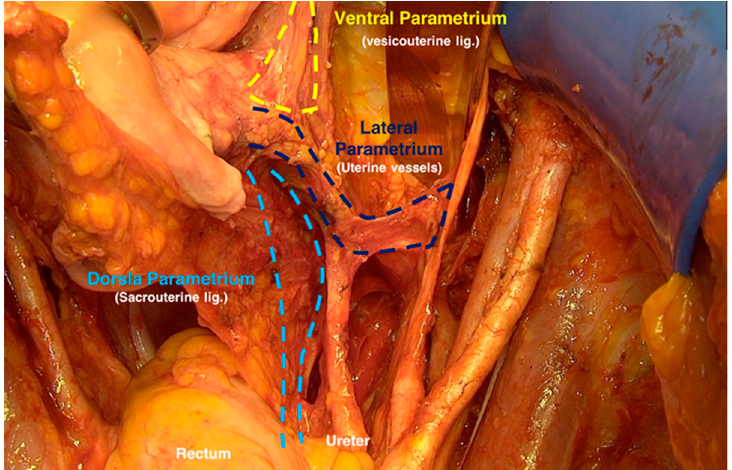
Figure 1. Identifying the ventral, lateral, and dorsal parametrium after preparing the paravesical and pararectal spaces.